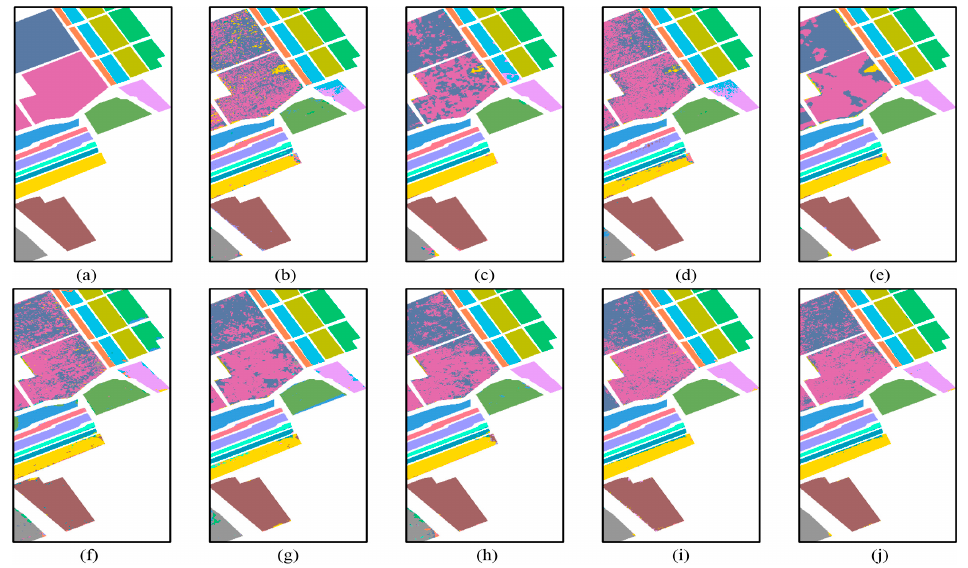
Figure 9. Ground truth and classification maps for the Salinas data set. ( a ) Ground truth. ( b ) KSRC. ( c ) MASR. ( d ) CRT. ( e ) KFRC ‐ CKIR. ( f ) MF ‐ SRC. ( g ) MF ‐ JSRC. ( h ) MFASR. ( i ) MFCARC. ( j ) MFCART.